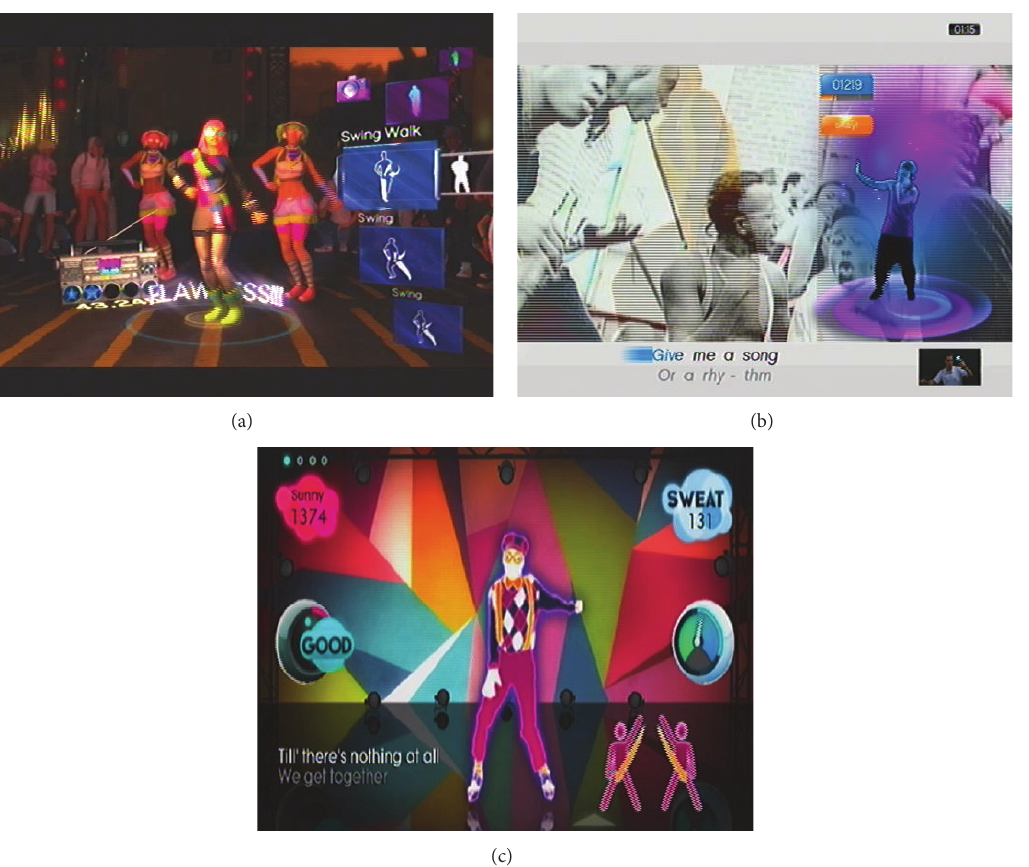
Figure 1: Game play screen shots for each body motion tracking peripheral. (a) Kinect (Dance Central), (b) Playstation Move (SingStar + Dance), and (c) Wiimote (Just Dance